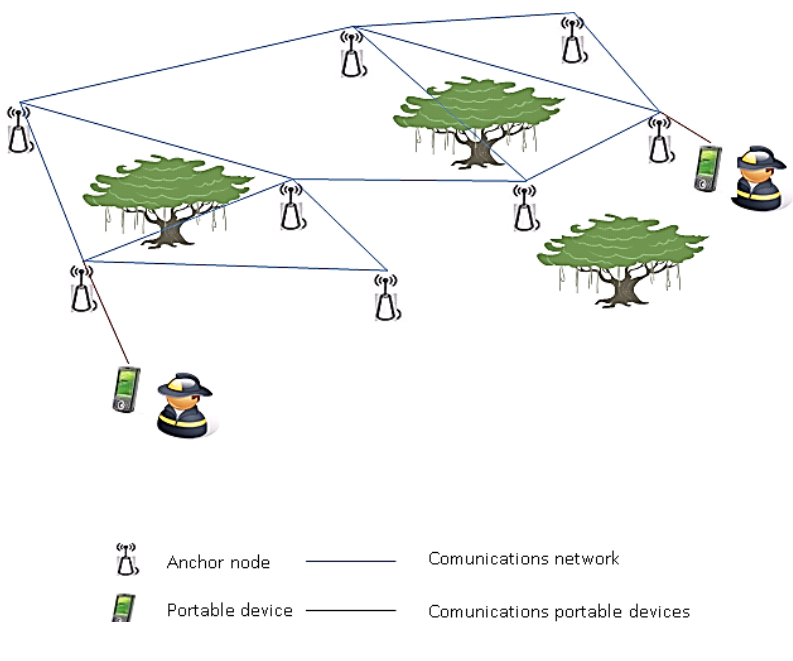
Figure 12. SIPIRSI